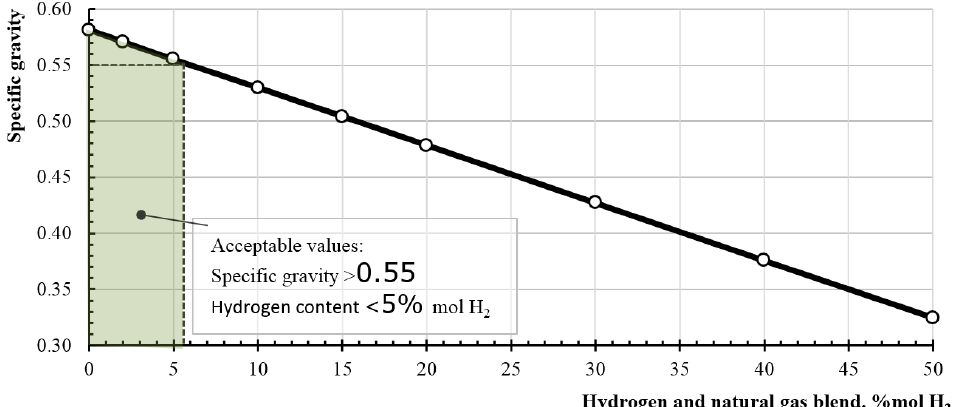
Fig. 3. Specific gravity based on hydrogen content.